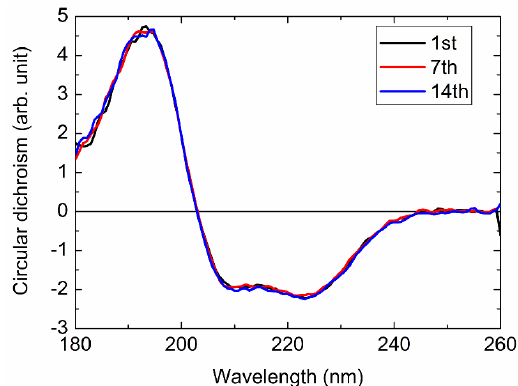
Figure 5. CD spectra of myoglobin obtained by consecutive scans for 1 h. 1st scan: black, 7th scan (0.5 h later): red, and 14th scan (1 h later): blue.